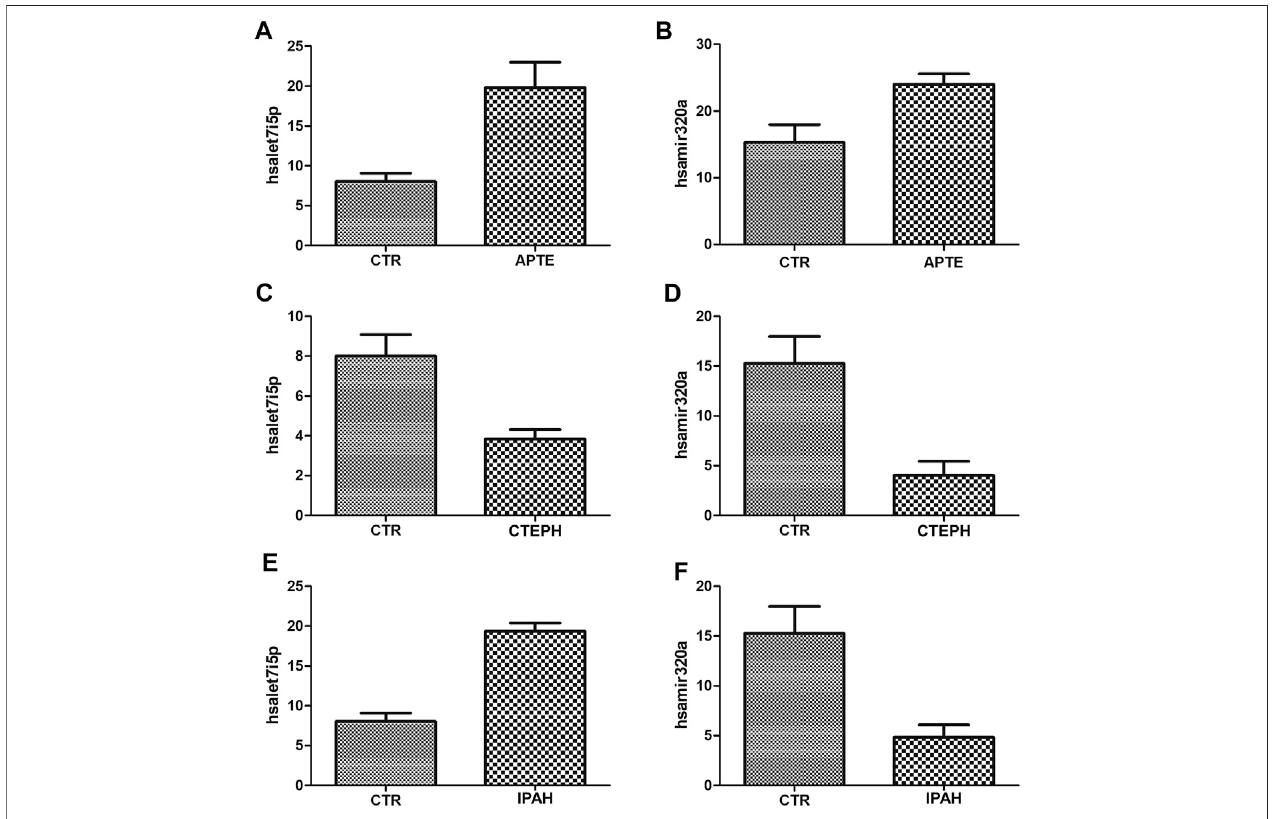
FIGURE 6 | (A) – (F) Plot graphs of the expression of miRNAs in APTE, CTEPH and IPAH samples compared with that in control samples by qRT-PCR. * p < 0.05 (Independent-Samples Mann – Whitney test). APTE group n (cid:2) 5; CTEPH ( N (cid:2) 6), IPAH ( N (cid:2) 6) and CTR ( N (cid:2) 4). APTE, acute pulmonary thromboembolism; CTEPH, chronic thromboembolism pulmonary hypertension; iPAH, idiopathic pulmonary hypertension; CTR, healthy subjects; qRT-PCR, Quantitative Reverse-Transcription.